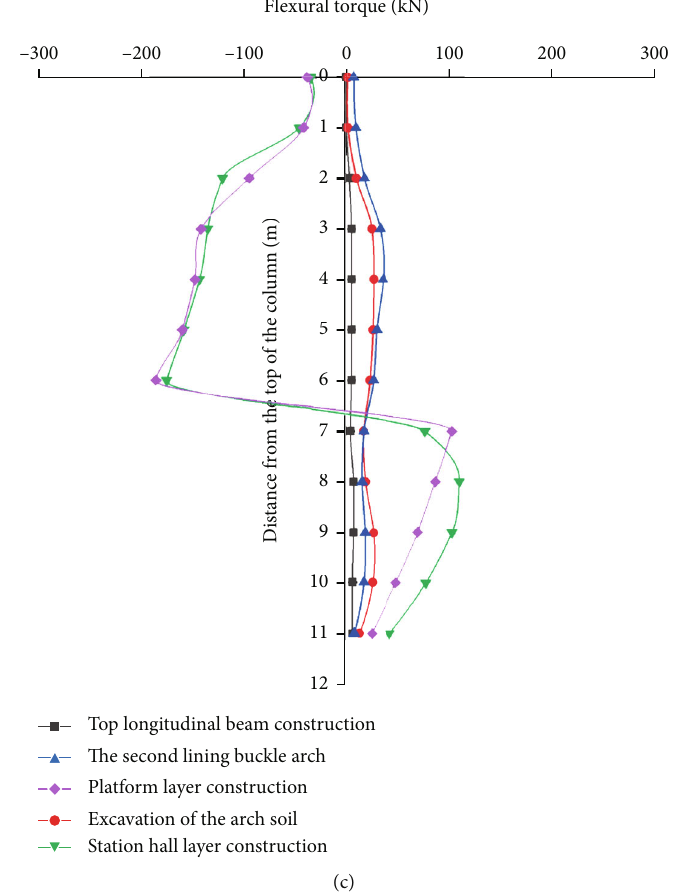
Figure 7: Internal force changes. (a) Variation of the axial force of the middle column. (b) Distribution of the axial force of the central column from top to bottom in each stages. (c) Distribution of the fl exural torque force from top to bottom in di ff erent construction stages.